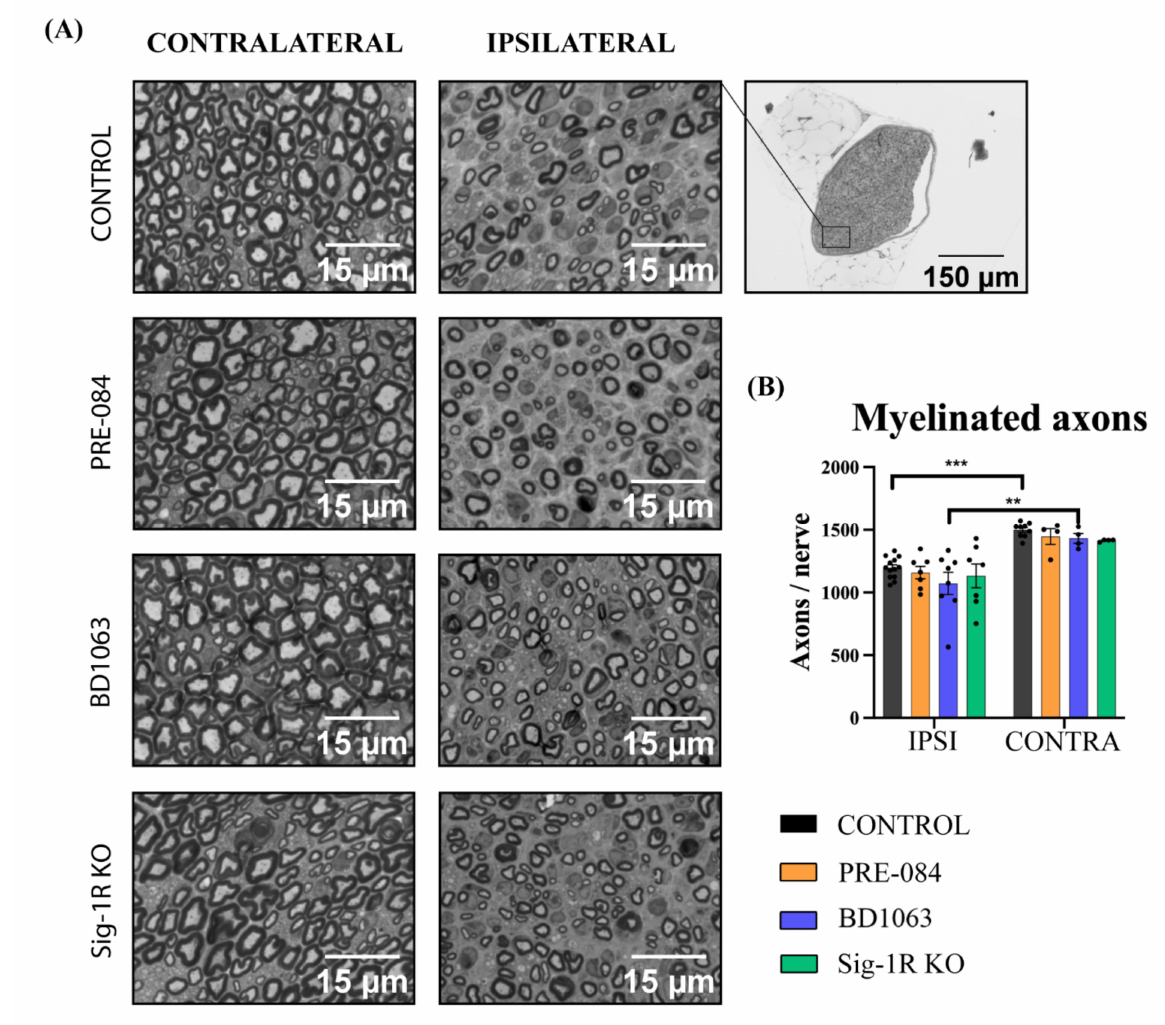
Figure 6. Myelinated axons in the regenerated tibial nerve. ( A ) Representative images ( × 100) of the tibial nerve in each group, ipsilateral (IPSI) and contralateral (CONTRA) to the injury; ( B ) Number of myelinated axons for each group in the studies of Sig-1R ligands and the Sig-1R KO mice. Values are mean ± SEM, analyzed by two-way ANOVA and Bonferroni post-hoc test: ** p < 0.01, *** p < 0.001 ipsilateral vs. respective contralateral nerve. PRE-084 or Sig-1R KO: n = 7 IPSI, n = 4 CONTRA; BD1063: n = 8 IPSI, n = 4 CONTRA; control: n = 13 IPSI, n = 9